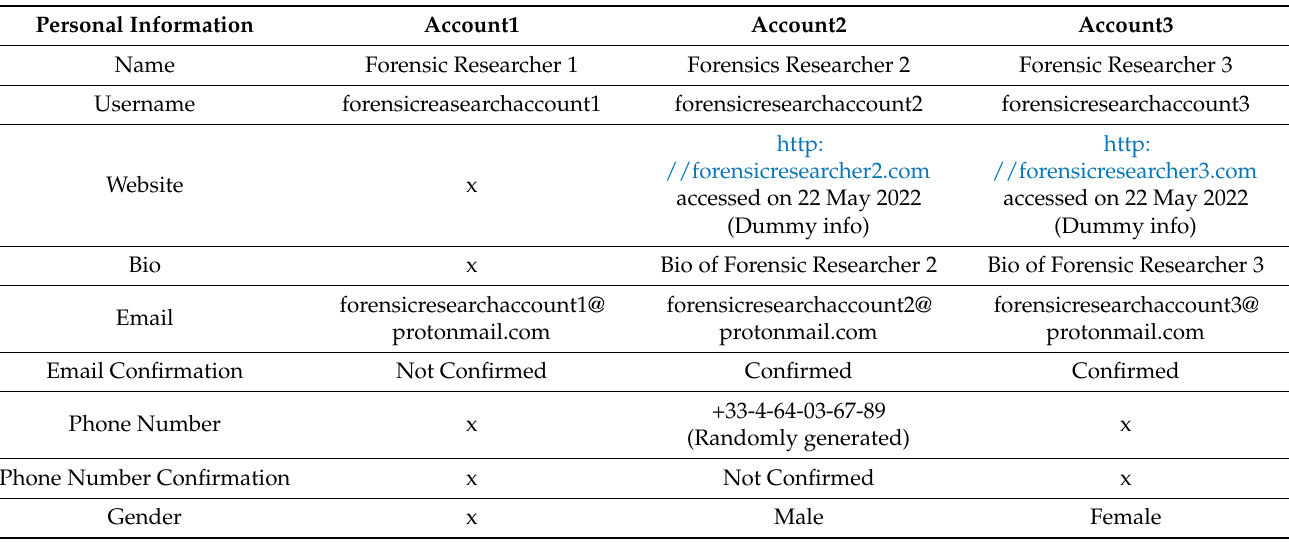
Table 3. User Accounts Utilized in